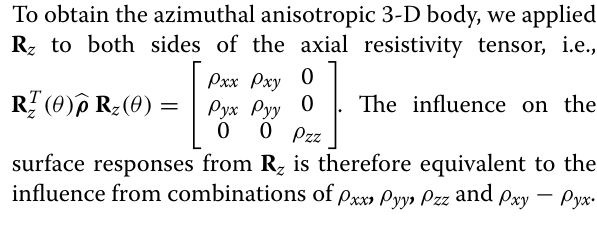
Fig. 9 The logarithmic plots of Z inf xx , Z inf yy , Z inf xy , and Z inf yx , and T edge x , and T edge y on the x ‑axis for the case of R T y ( 45 ◦ )